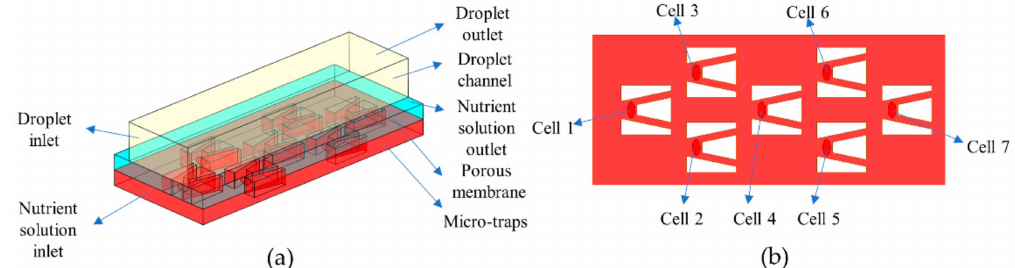
Figure 2. Three-layer sandwich structure of PDMS/PCTE microporous membrane/PDMS microfluidic chip: ( a ) computational zone of cell dosing microfluidic chip; ( b ) the number of cells trapped in micro-traps.